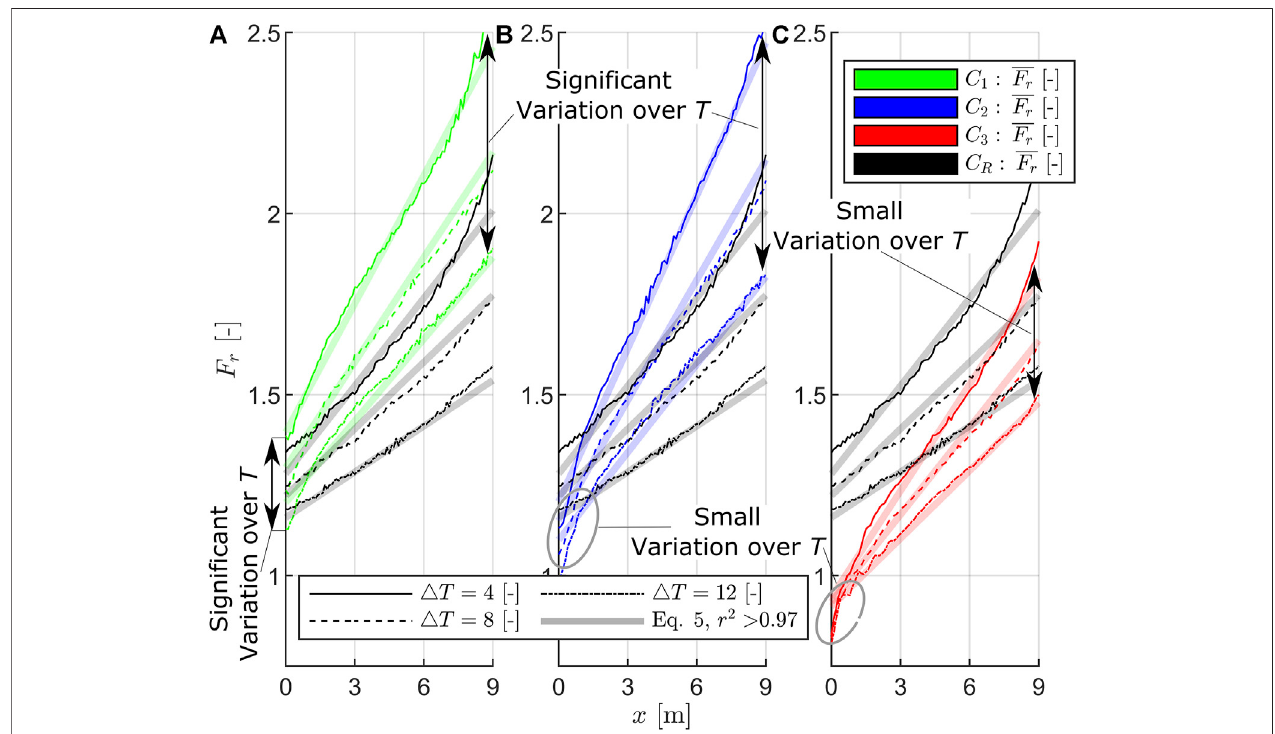
FIGURE13| Visualizationofclass-averaged Froudenumbers(thinlines)over space (atthehorizontal plane) atthree dimensionless instantsintime Δ T (cid:1) [ 4 , 8 , 12 ] . Data are displayed separately per class (A – C) . The multilinear approximation is displayed as wide transparent lines.